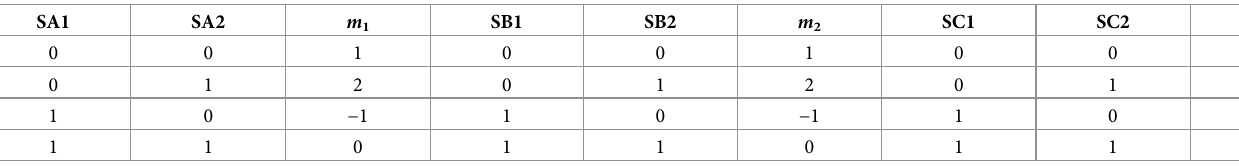
Table 1. Relationship between the on-off state of the switch tube and m 1 , m 2 , m 3